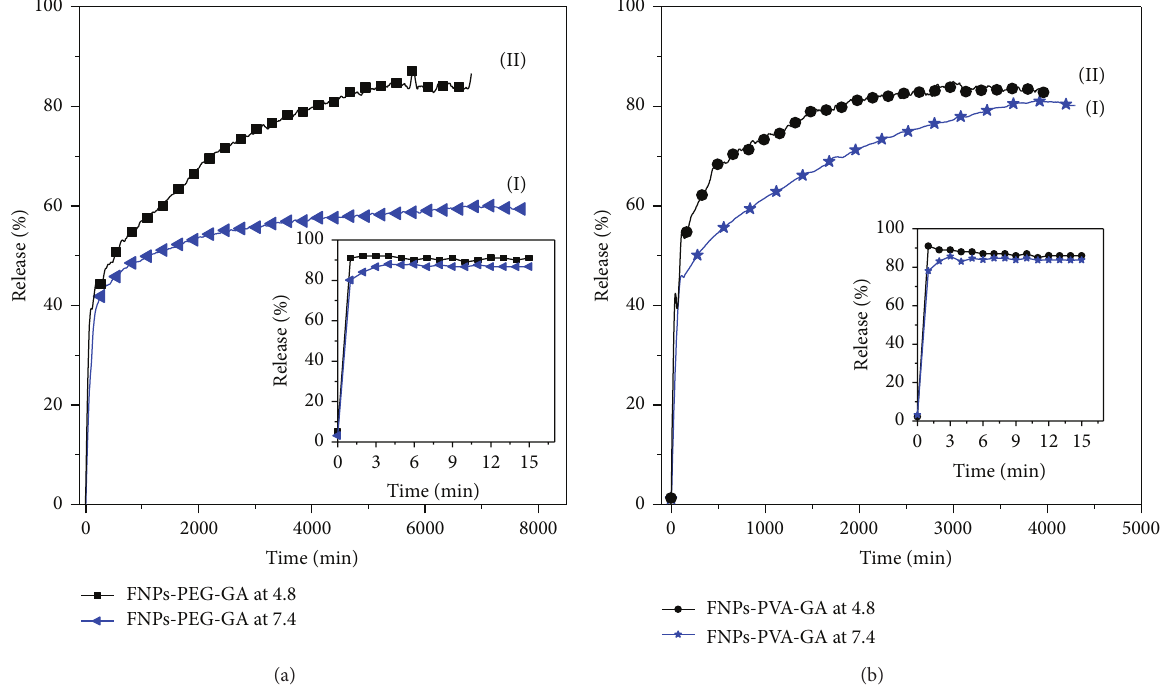
Figure 6: (a) Release profiles of GA from the FPEGG nanocomposite into (I) phosphate buffered solution at pH 7.4 and (II) phosphate buffered solution at pH 4.8 and (b) release profiles of GA from the FPVAG nanocomposite into (I) phosphate buffered solution at pH 7.4